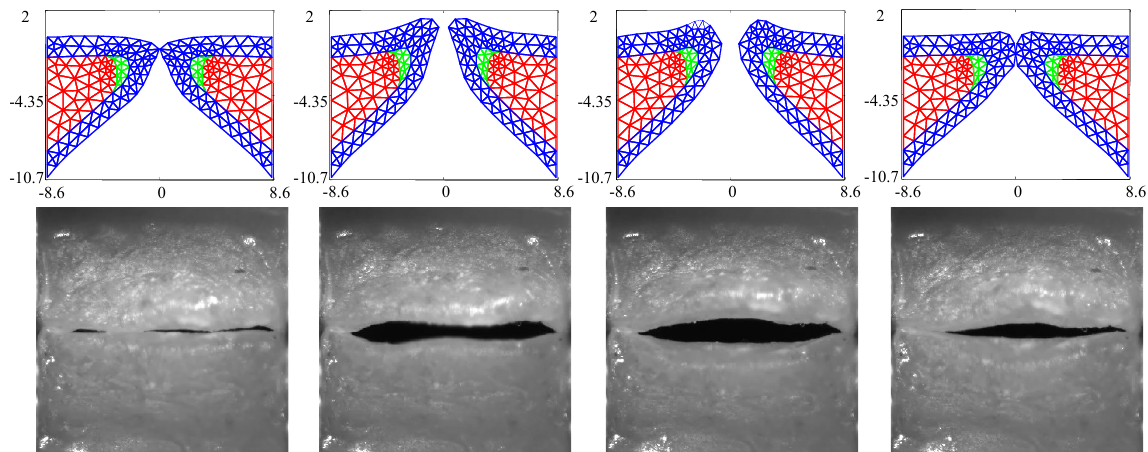
Figure 3. Kinematics of the FE model in comparison with the observed high speed videoendoscopy (HSV) for the case with no medial compression ( p sub = 1kPa) at several time points throughout a single oscillation cycle.